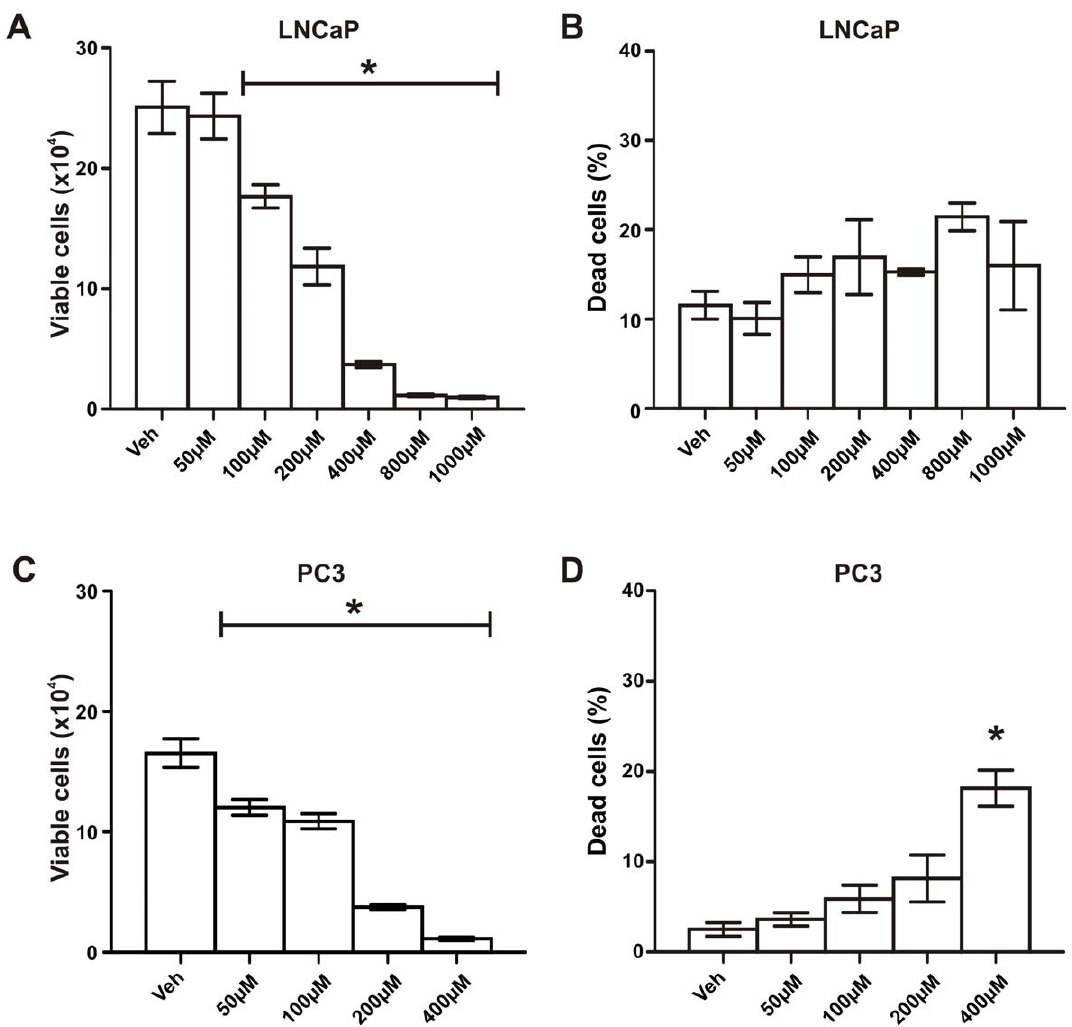
Figure 5. Effects of Zebularine treatment on LNCaP and PC3 prostate cancer cell viability and cell death. (A-B) LNCaP and (C–D) PC3 prostate cancer cells (1 6 10 4 cells per well in 12-well plates) were treated with increasing doses of Zebularine (0–400 m M, up to 1000 m M for LNCaP cells) replenished once on day 4 for a period of 6 days for PC3 cells, and 8 days for LNCaP cells. (A) and (C) cells were counted at regular intervals using a hemocytometer and cell viability was assessed by Trypan blue dye exclusion. (B) and (D) the number of dead cells is expressed as a percentage of the total number of cells counted. Data at each time-point represents the mean + / 2 SE of triplicate wells. *One-way ANOVA; p , 0.0001 for (A) and (C); p=0.0004 for (D) compared to vehicle control (veh).